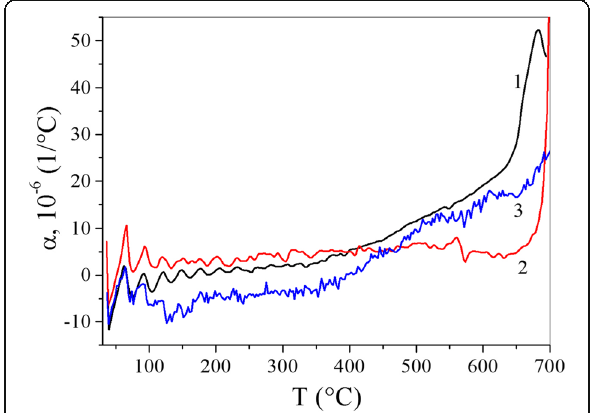
Fig. 2 Variation with temperature of the coefficient of thermal expansion measured in the direction perpendicular to the rolling plane of Cu-Ti ( 1 ), Cu-Ti 1 vol% MWCNTs ( 2 ) and Cu-Ti 3 vol% MWCNTs ( 3 )